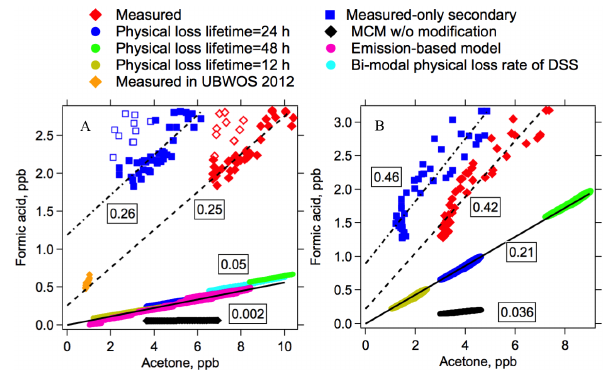
Figure 6. Scatter plots of formic acid vs. acetone in UBWOS 2013 (a) and CalNex (b) . The measured values are 30min diurnal- averaged data. The measured values in UBWOS 2012 are also shown in (a) . The last-day diurnal results from the diurnal steady state (DSS) box model simulations are shown. Model results from the emission-based model and the DSS simulations using bimodal physical loss rates in UBWOS 2013 are also shown. Dashed and dash-dotted lines show fitted results from measured concentrations and estimated secondary concentrations, respectively. The fits in UBWOS 2013 exclude data in the 07:30–12:00 LT period (empty symbols, see text for details). Solid lines indicate the fitted results from model simulations with modified MCM in the two campaigns. Numbers in the graphs indicate enhancement ratios of formic acid to acetone from various data sets.